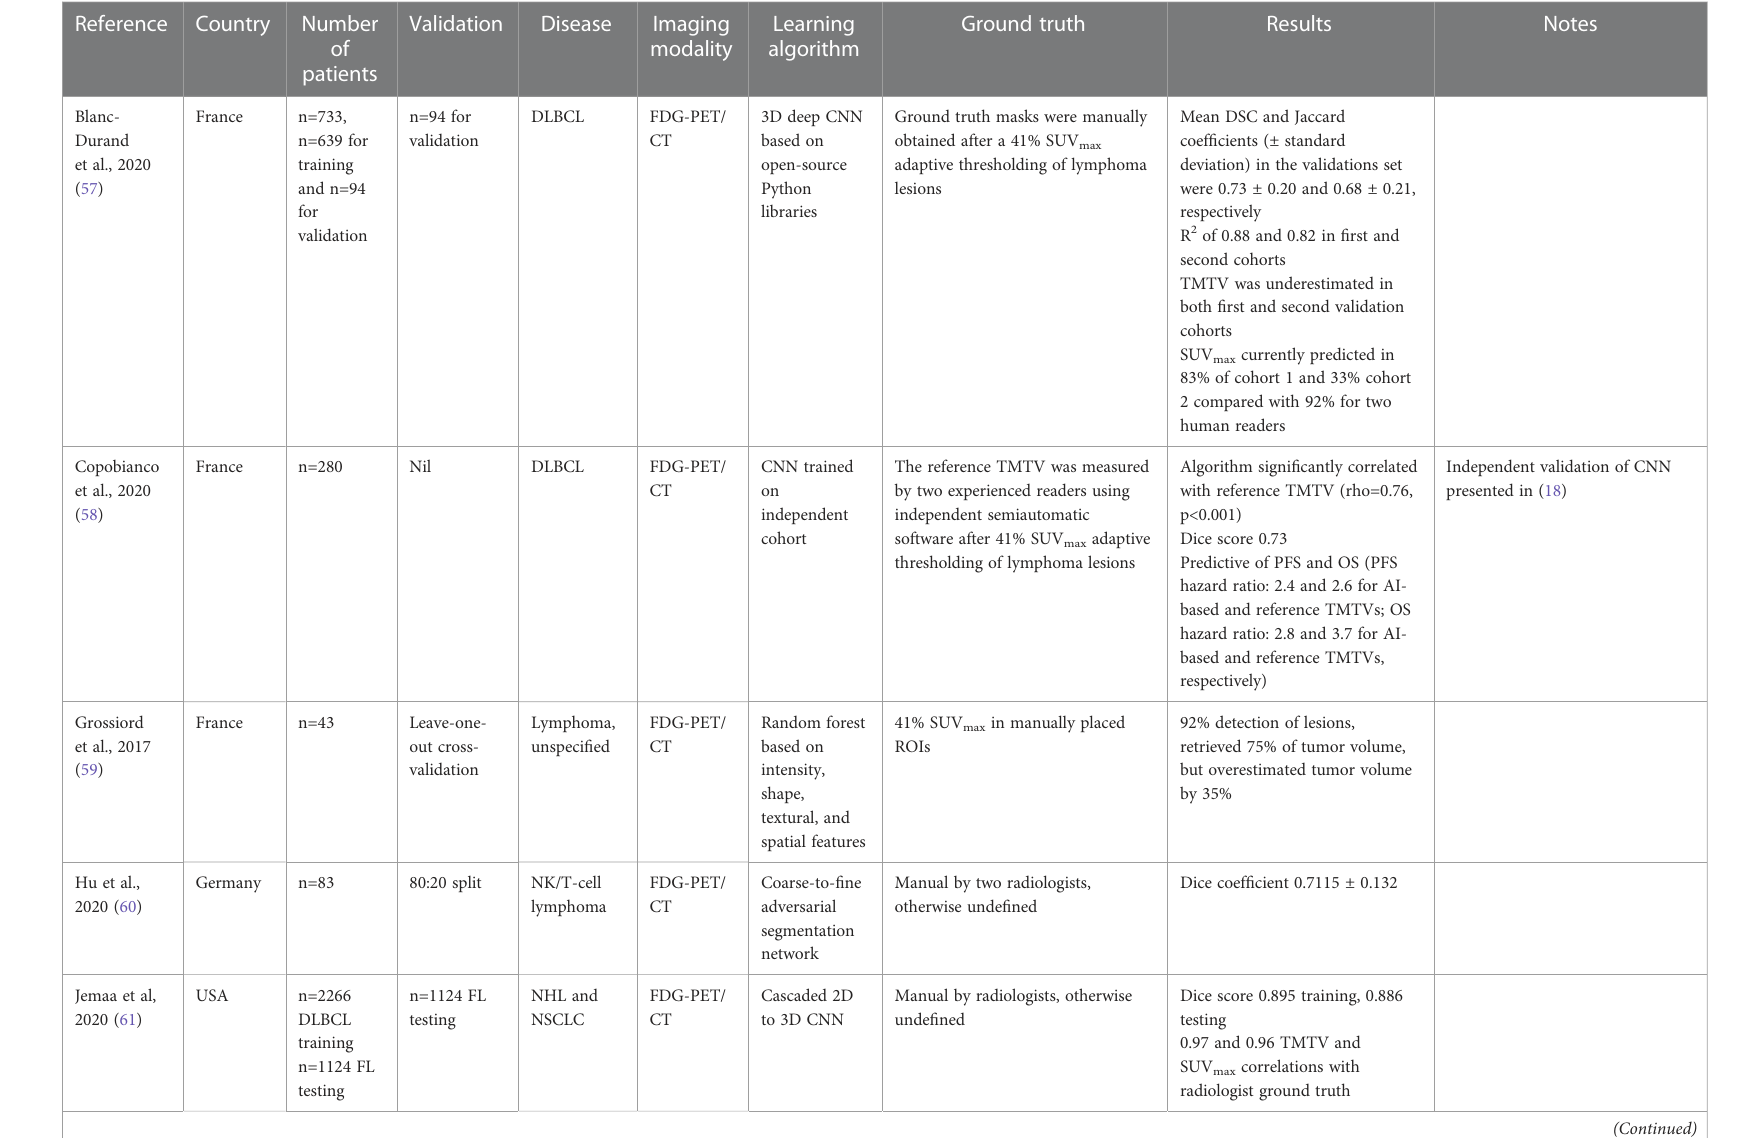
TABLE 2 Studies applying machine learning to segmentation